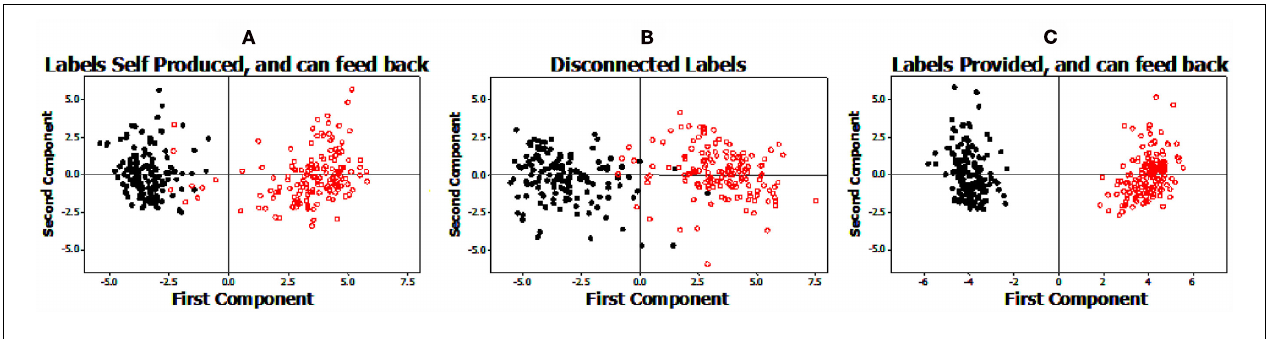
allowed to feed back onto the perceptual layer (A) .When this feedback of labels is disrupted by blocking the flow of activity from the label to the hidden layer, representations revert to reflecting the perceptual structure of the stimulus space (B) . Categorization is further enhanced when the label is provided to the network exogenously (C) . See text for additional